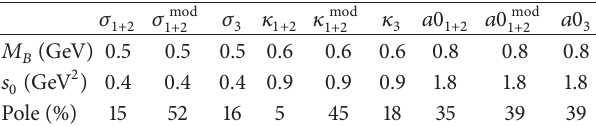
Figure 2: Various contributions to the correlation function of the current 𝜎 1+2 as functions of the Borel mass 𝑀 𝐵 in units of GeV 10 at 𝑠 0 = 0.4 GeV 2 . The labels indicate the dimension up to which the OPE terms are included. Table 2: Pole contributions of various currents.